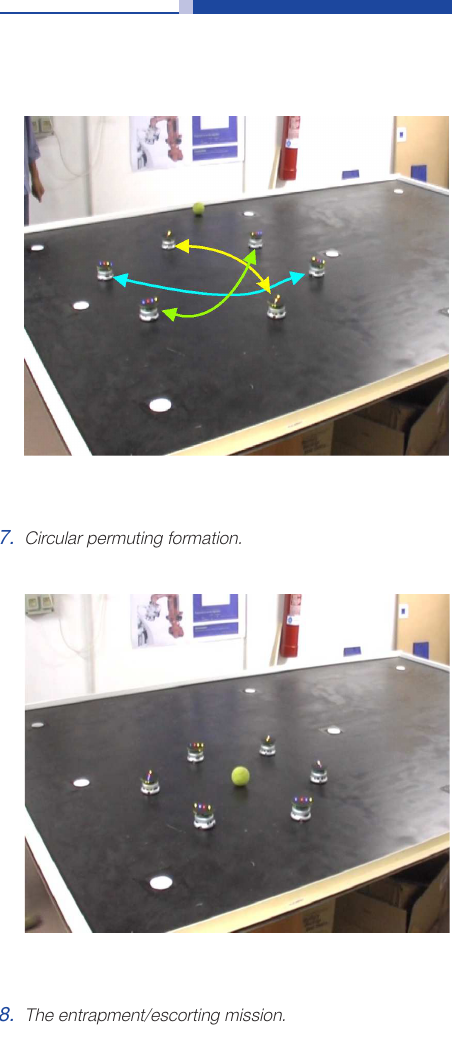
Figure 8. The entrapment/escorting